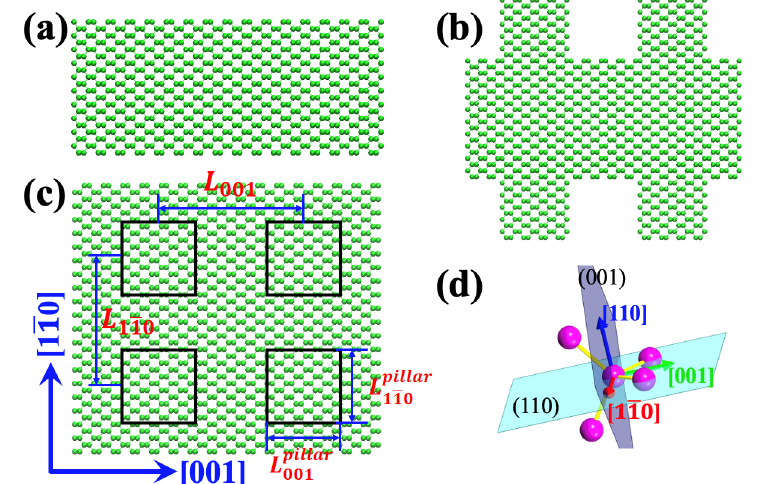
Figure 1. Schematic illustration of ( a ) side view of a pristine Si membrane with {110} surfaces, ( b ) side view of a resonant {110}-Si membrane, ( c ) top view of a resonant Si membrane with pillars located at the black rectangles and ( d ) relative orientations between the four bonds of a silicon atom, the {110} facet and transport